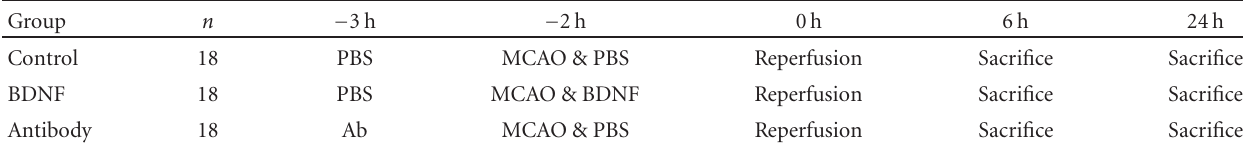
Table 1: Procedure of the experiment.